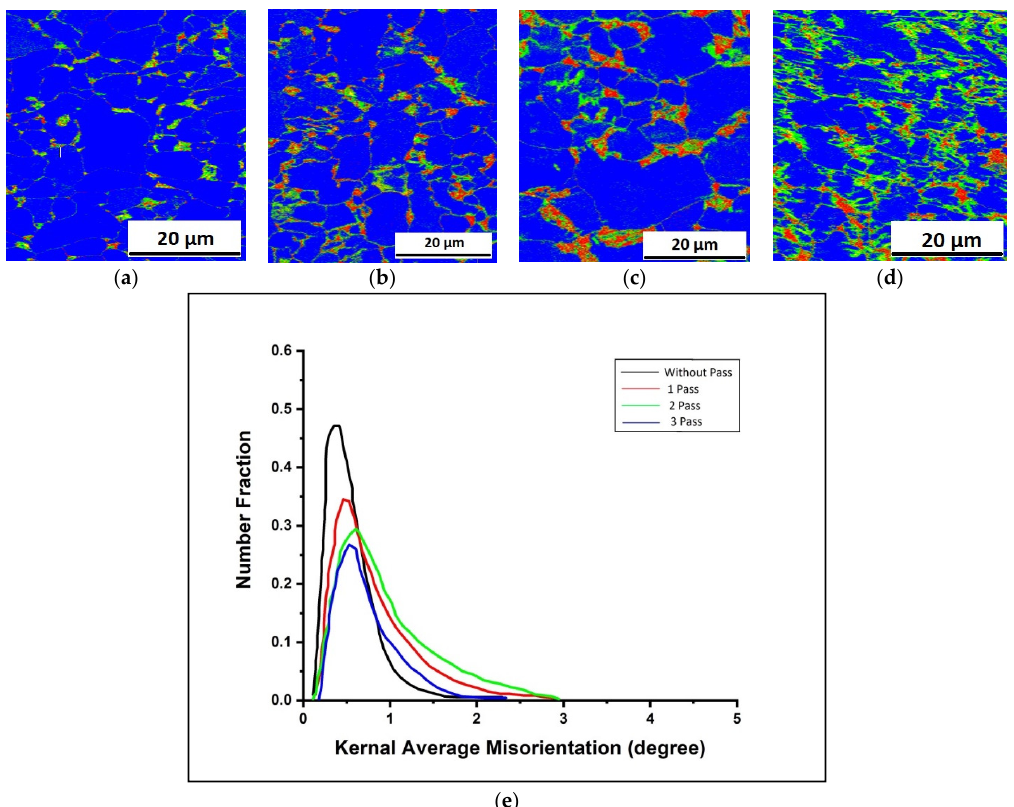
Figure 8. Kernel Average misorientation micrographs of ( a ) As received and ECAPed after ( b ) first pass, ( c ) second pass, ( d ) third pass. ( e ) Kernels average misorientation (KAM) plots at ambient